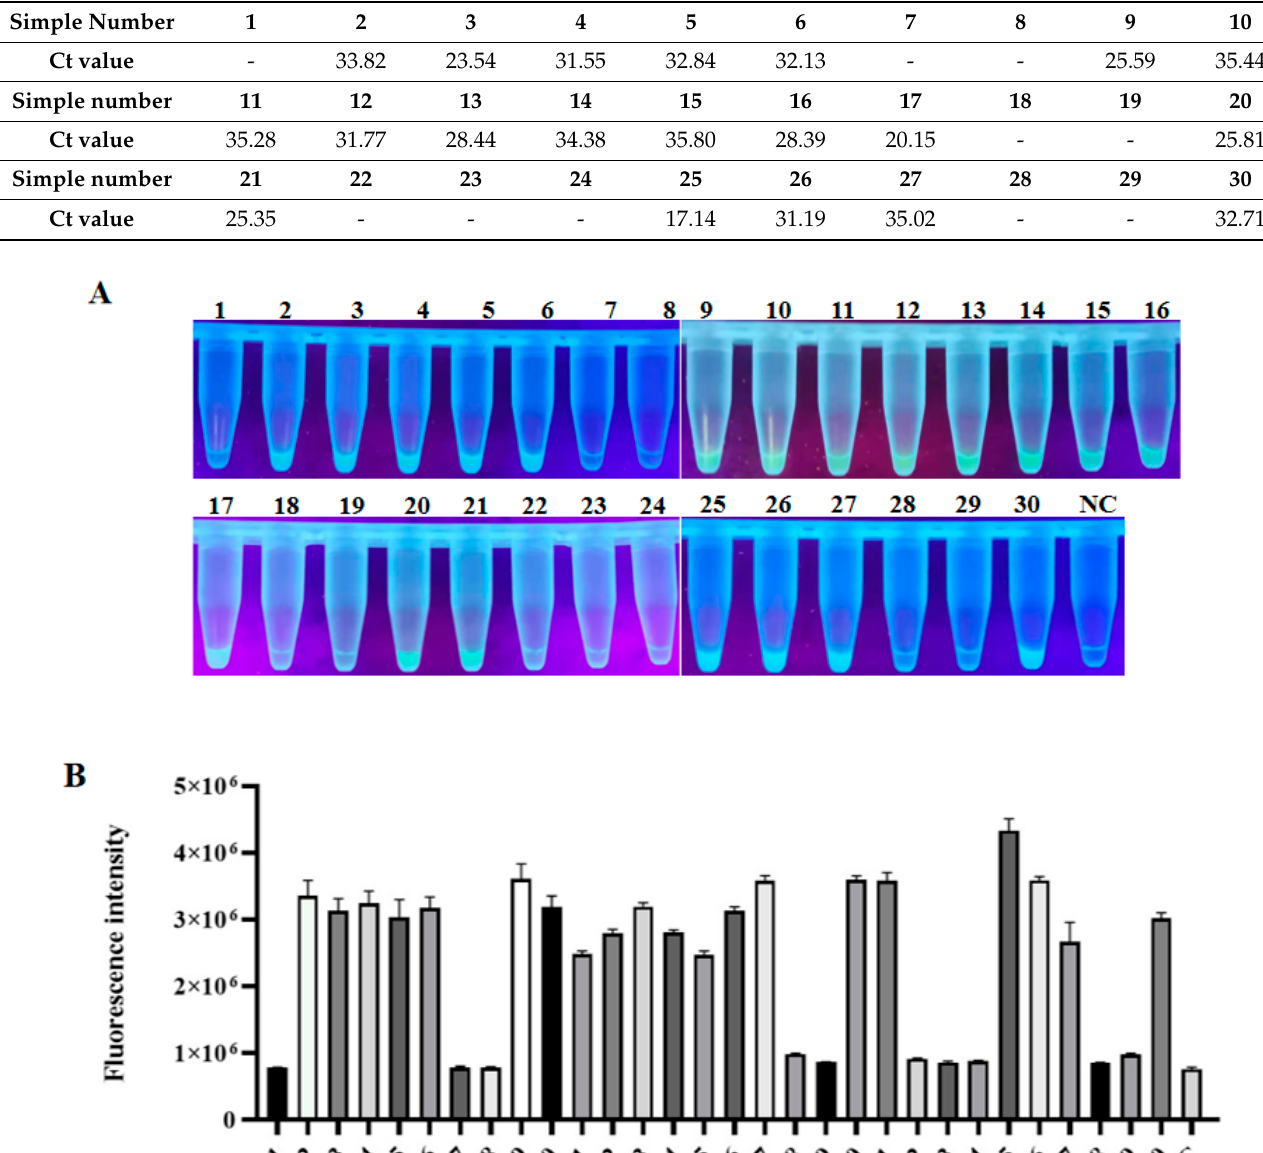
Table 1. The results revealed by qPCR in detecting PCV2 among clinical samples. The Ct value represents the threshold cycle value.